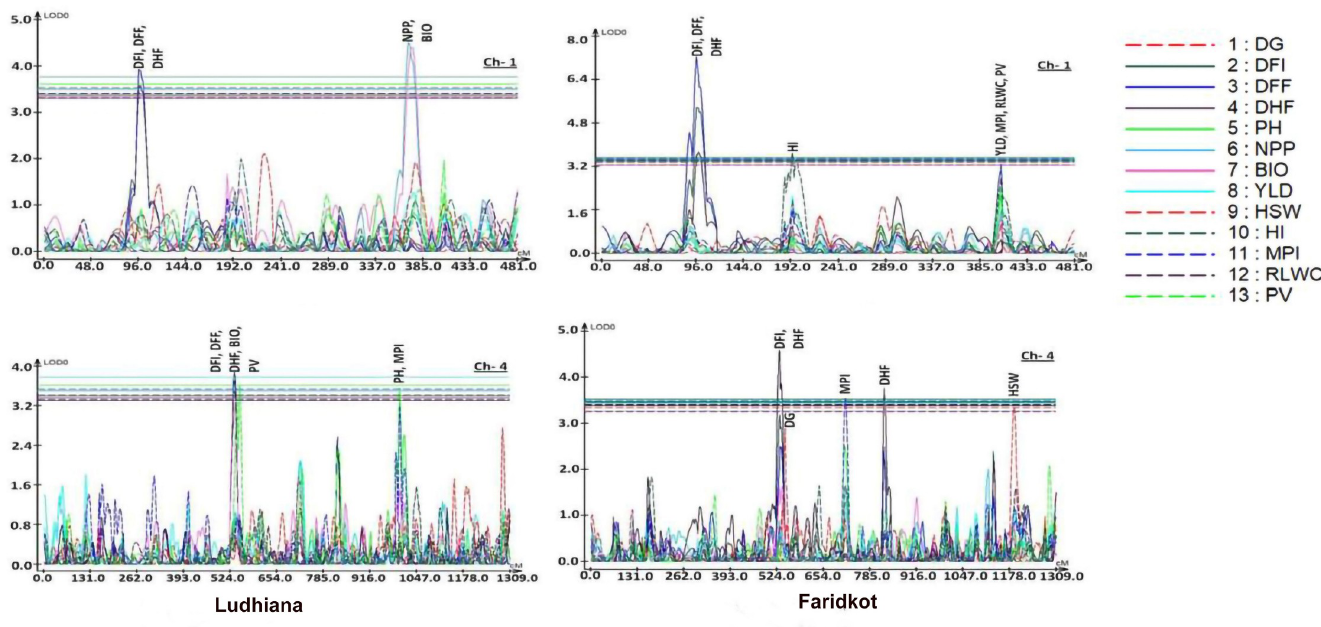
Fig 4. Logarithm of odds ratio (LOD) curves obtained by composite interval mapping for quantitative trait loci (QTLs) mapped for different traits in RIL population (GPF 2 × C . reticulatum acc ILWC 292) in heat stress environment.